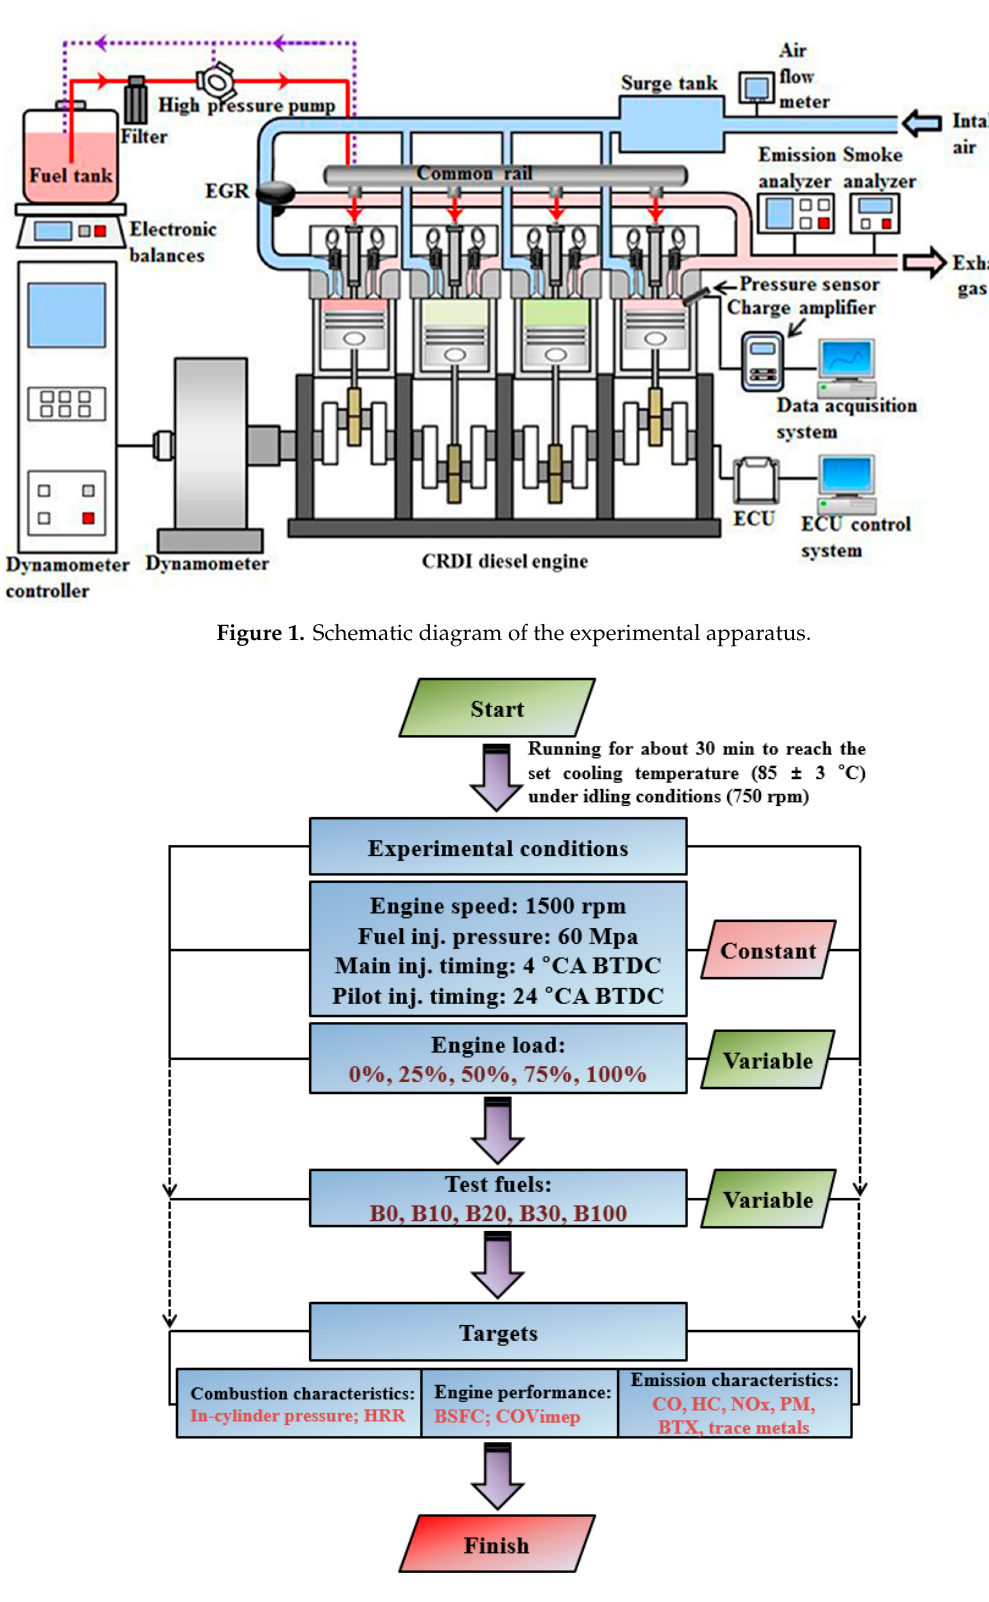
Figure 2. Flow chart for the engine